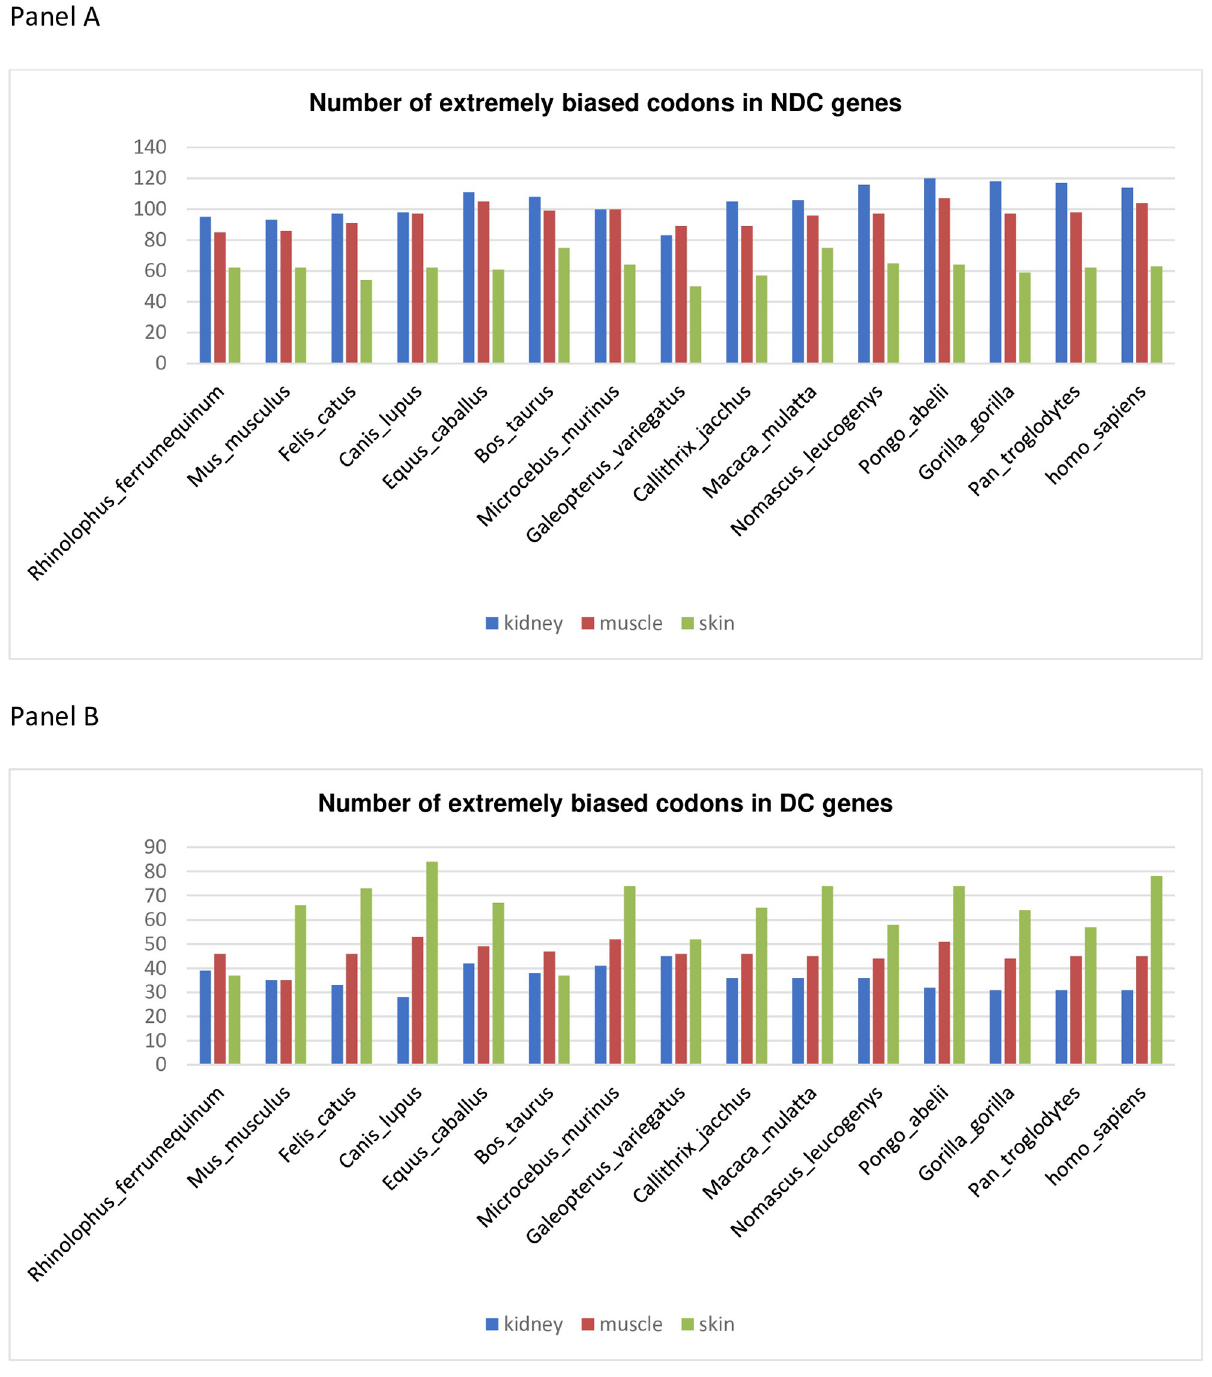
Fig 5. Number of extremely biased codons (“zero-codons”) found in DC and NDC tissue-specific genes across mammals. Panel A and B show on graphs the same data reported in Table 1, to better appreciate the CUB trend and the number of “zero codons”. Specifically, the number of extremely biased codons (“zero-codons”) in NDC and DC gene tissues are shown in panel A and panel B, respectively. On the X-axis are listed the mammals’ species in an evolutionary order; in the Y-axis the cardinal number of “zero codons”. Blue, red, and green bars represent kidney, muscle, and skin tissues genes,